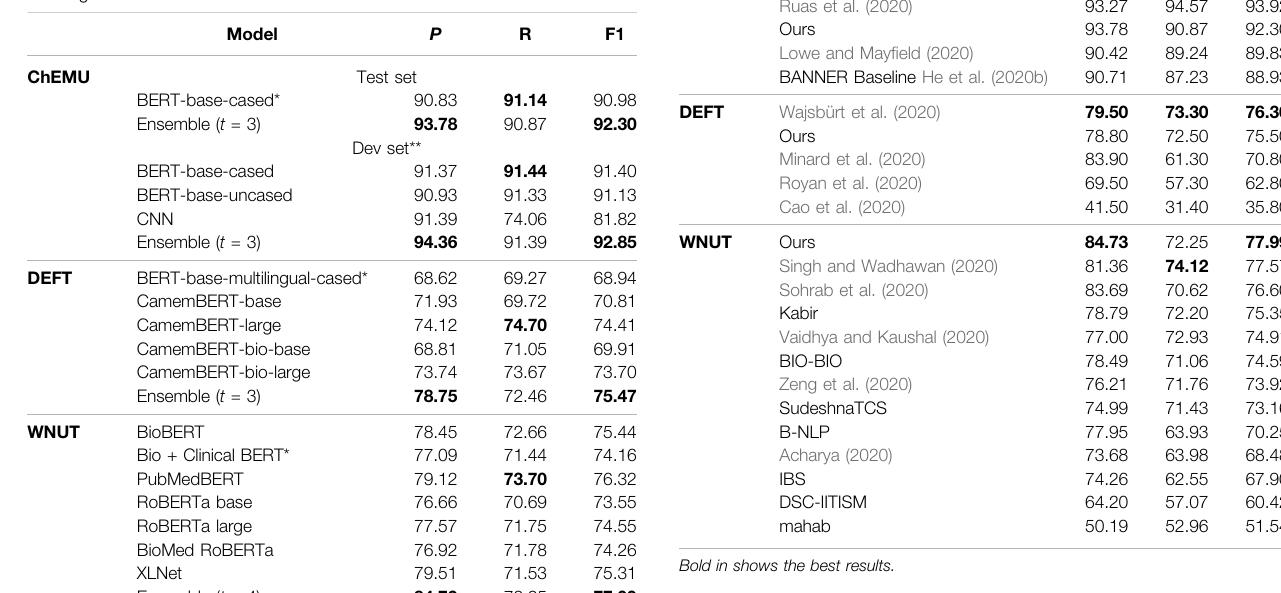
TABLE6| Comparison oftheensemblemodelwiththeindividualmodelsonthree datasets (ChEMU, DEFT, and WNUT). *Individual model was taken as referencefortheindividualmodel ’ sbaseline.**Theof fi cialtestsetofChEMUisnot publicly available, so we report the results on the development set that was used asatest set (the training set was splitinto training and developmentsets). The comparison of individual models and ensemble for the DEFT and WNUT challenges are on the of fi cial test sets.